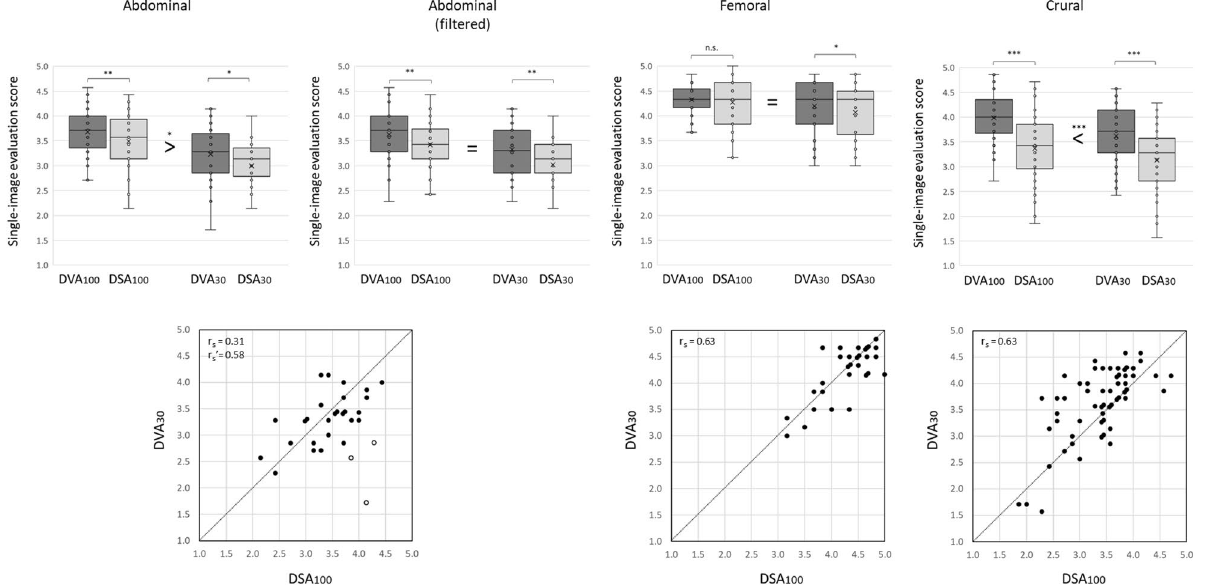
Figure 3. Comparison of single-image evaluation scores in three anatomical regions. The box and whisker plots (upper row) show the median (line), mean (x), interquartile range (box) and internal fences (whiskers). The image processing technologies (DVA vs DSA) were compared by the Wilcoxon signed ranked test. whereas the non-inferiority of low-dose DVA images compared to normal dose DSA images (denoted by relation signs) was analysed by the one-sample Wilcoxon test (* p < 0.05, ** p < 0.01, *** p < 0.001, = identical image quality, < superior image quality). The scatter plots (lower row) show the correlation of DSA100 and DVA30 scores with the Spearman correlation coefficients (r s ). Each point represents the mean score of a normal dose DSA100 and the corresponding low-dose DVA30 image taken from the same patient and same position. Juxtaposed points show images with identical DSA and DVA scores. Open circles in the abdominal plot represent images obtained in the presence of large amount of intestinal gases (3 patients out of 30), r s ’ is the correlation coefficient without these points. The diagonal line separates points with higher DSA100 (below the line) or higher DVA30 scores (above the line). DSA: Digital Subtraction Angiography; DVA: Digital Variance Angiography, n.s. not significant. The index shows the applied protocol, 100: normal dose (1.2 µGy/frame), 30: low-dose (0.36